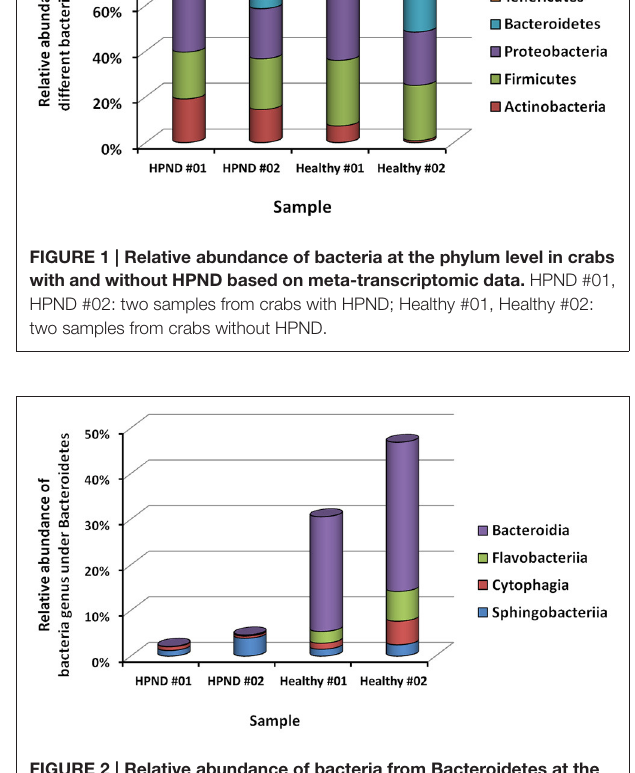
FIGURE 2 | Relative abundance of bacteria from Bacteroidetes at the class level in crabs with and without HPND. HPND #01, HPND #02: two samples from crabs with HPND; Healthy #01, Healthy #02: two samples from crabs without HPND.